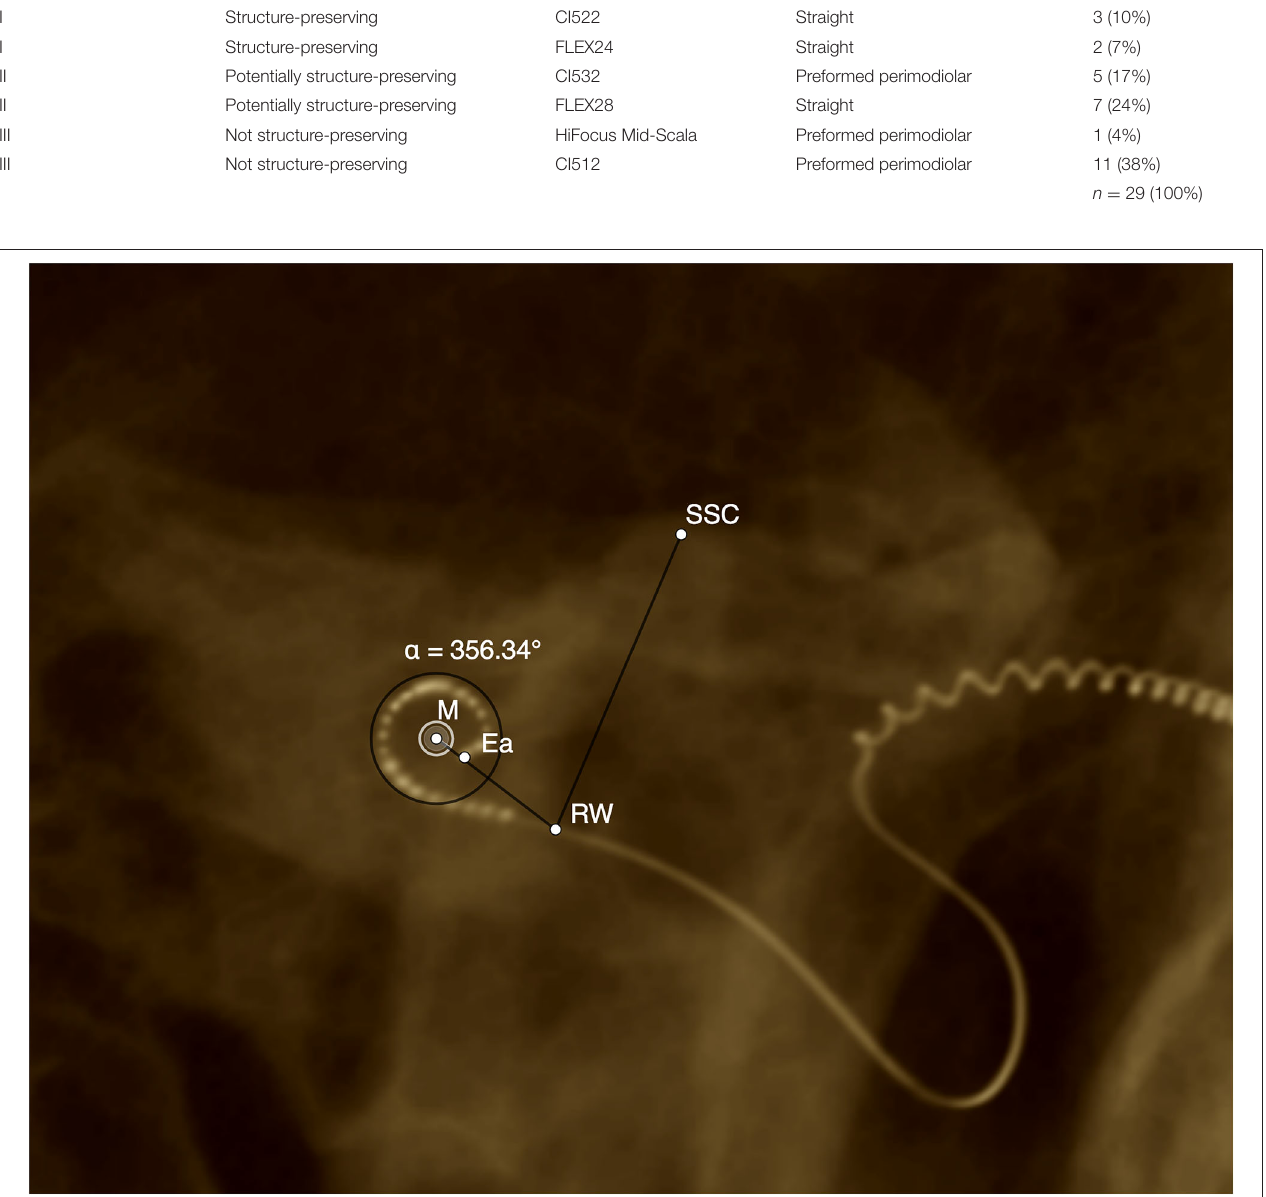
TABLE 1 | Implanted devices and electrode designs (for details on the devices and manufacturers, see section “Materials and Methods”). Electrode category